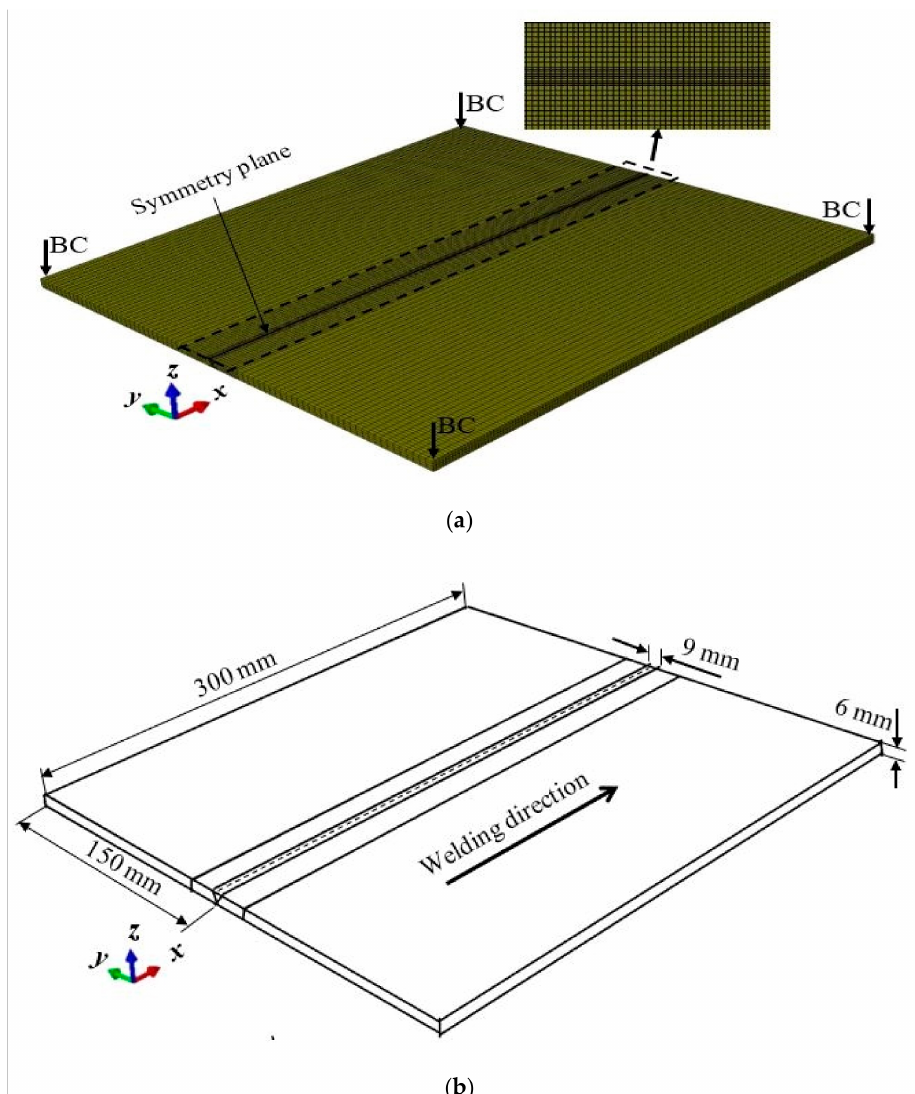
Figure 3. Three-dimensional FE model ( a ) FE mesh ( b ) dimension of the FE